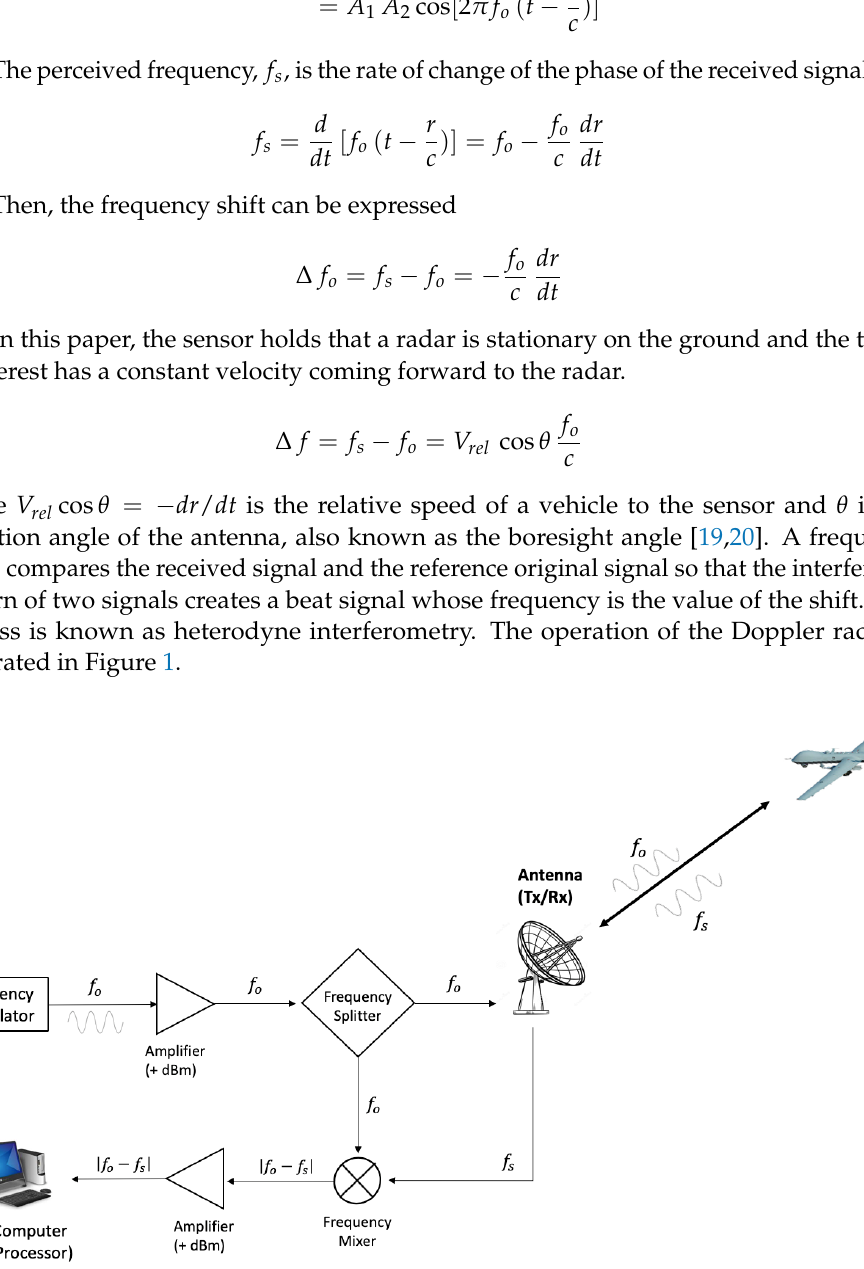
Figure 1. Doppler radar